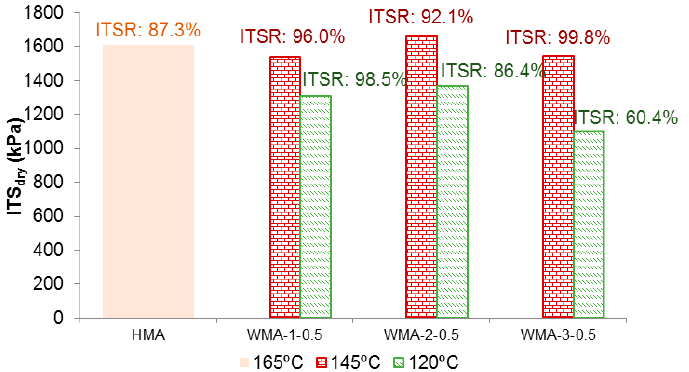
Figure 2. Indirect Tensile Strength (ITS) and Indirect Tensile Strength Ratio (ITSR) results for the mixtures with various additives.